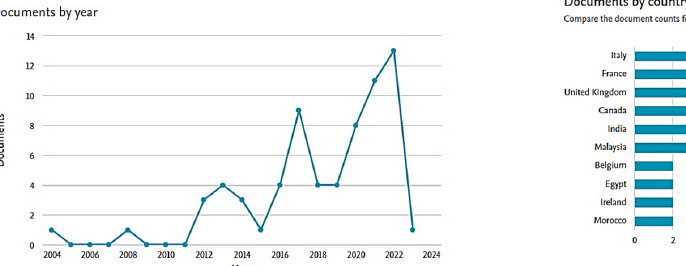
Fig. 2. Countries that published related to the words “brick” and “hemp” Source: Scopus scientific review